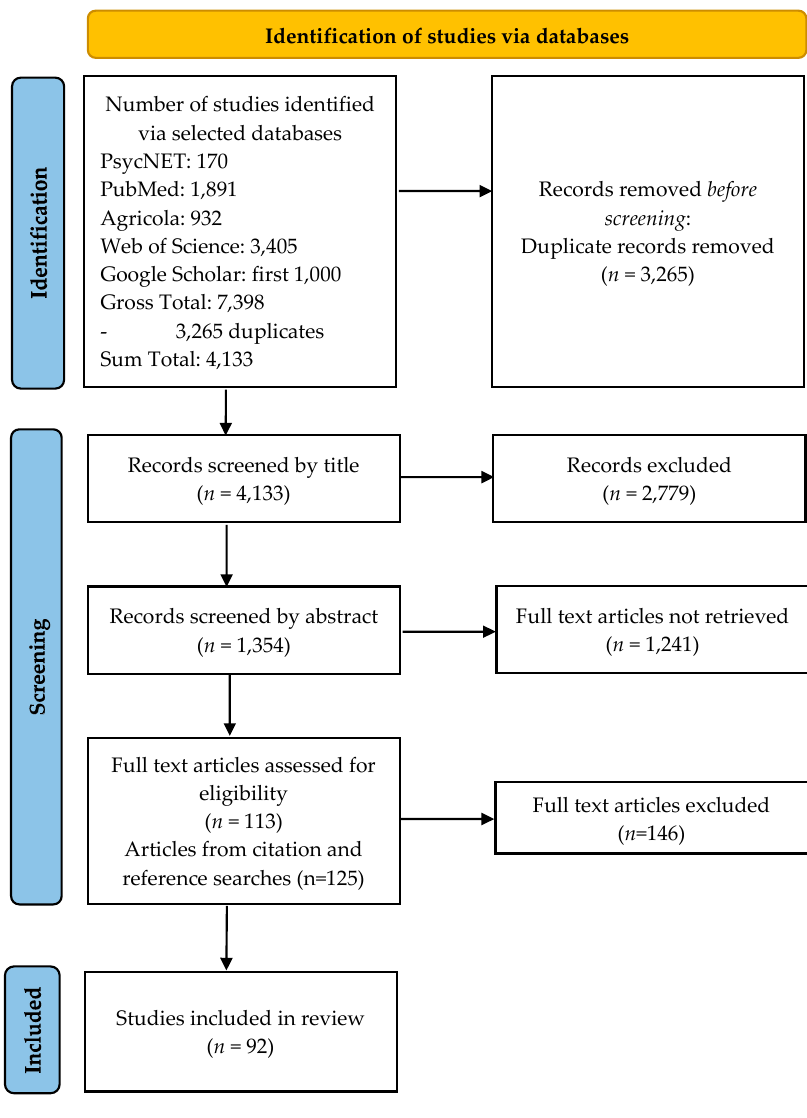
Figure 2. Schematic for identifying studies.